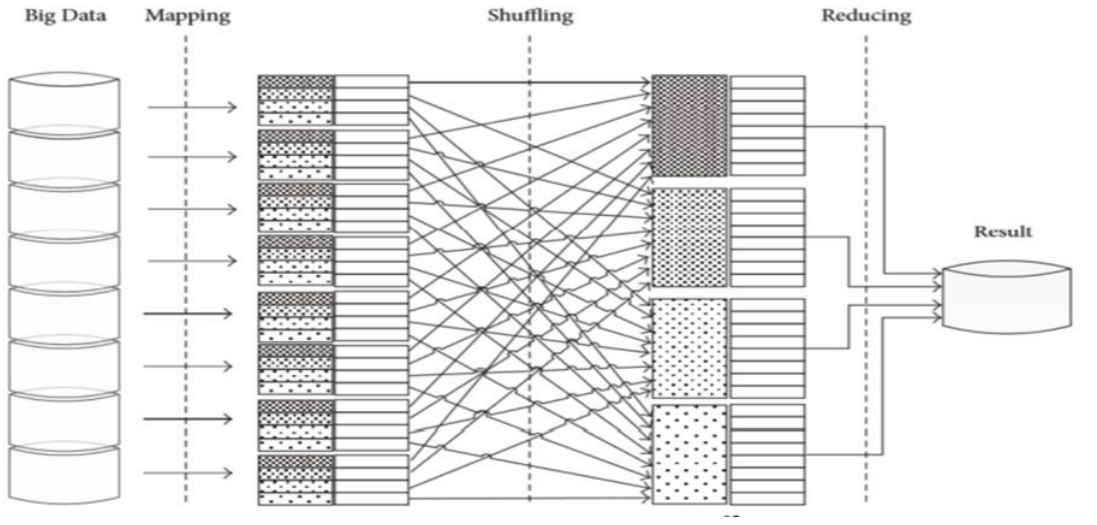
Figure 3: Map reduce functioning